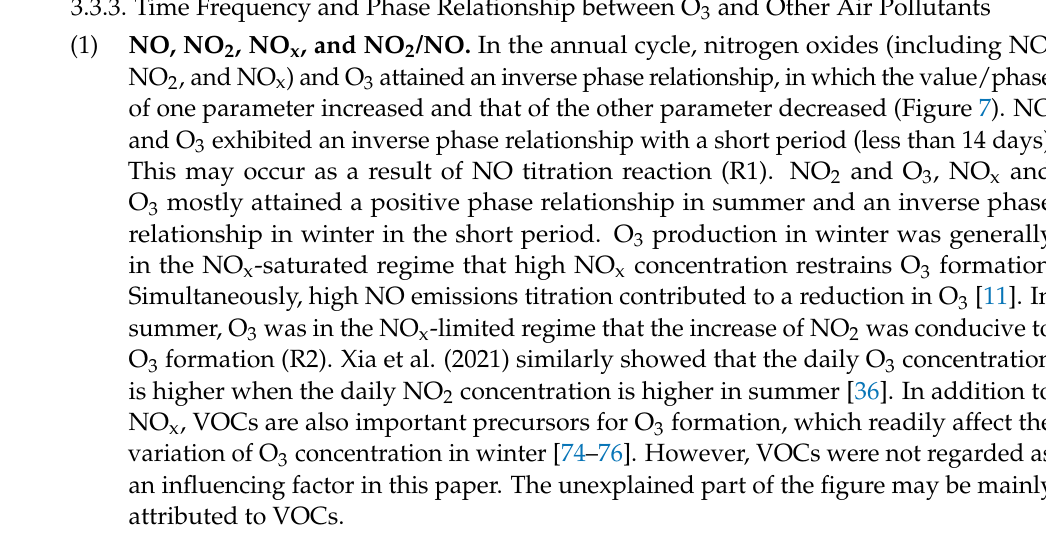
Table 2. ARsq (wavelet coherence coefficient) of meteorological conditions and other air pollu- tants with O 3 .